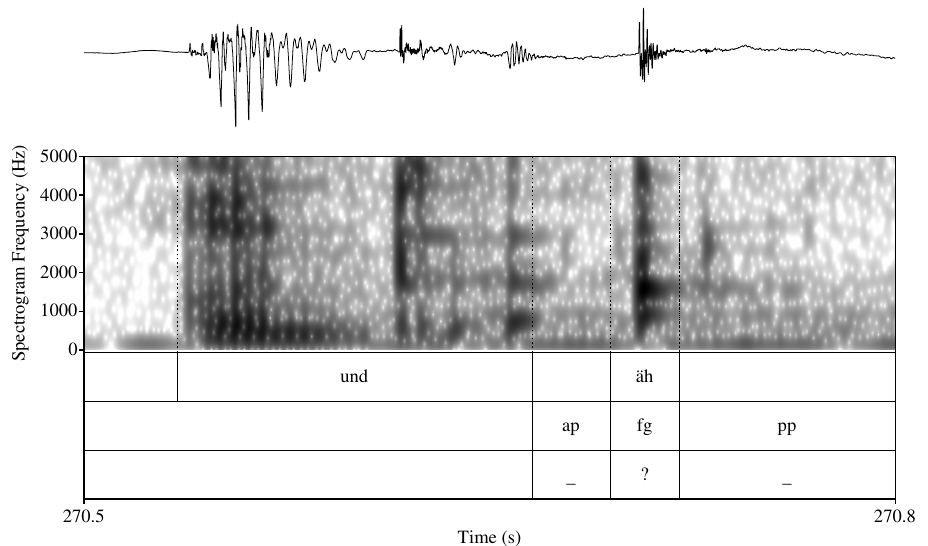
Figure 8. Example of glottal filler particle fg consisting of a singleton glottal stop [ P ] (23 ms) between two pauses ap and pp and following the conjunction und (source: bb_f_frei_f3).